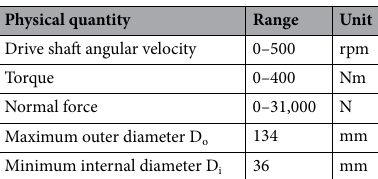
Table 2. Parameters of test stand 13